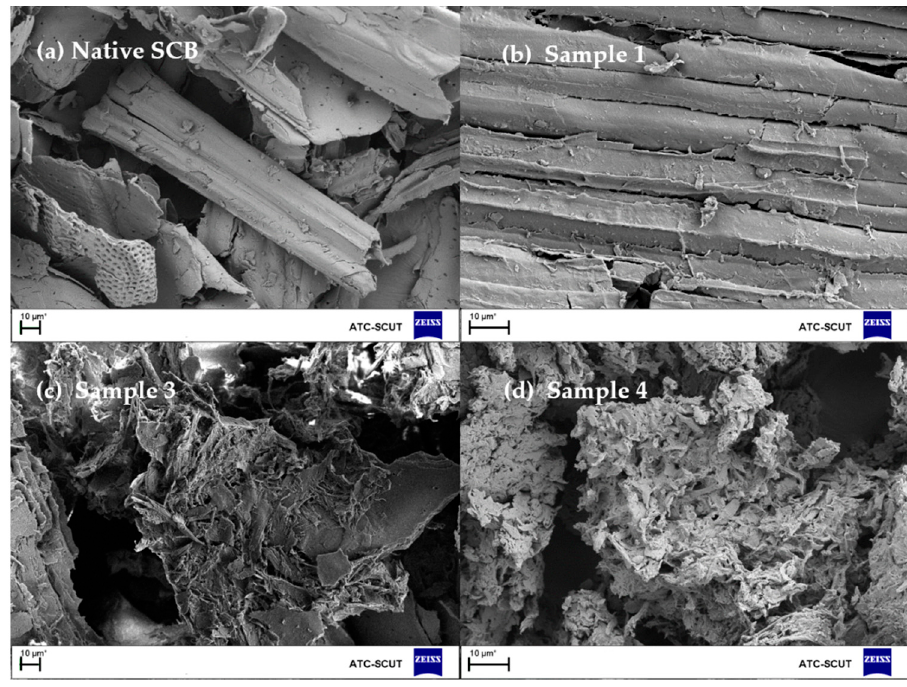
Figure 5. SEM images of native SCB ( a ) and SCB acetate obtained for 0.5 h (sample 1, b ), 2 h (sample 3, c ), 4 h (sample 4, d ).